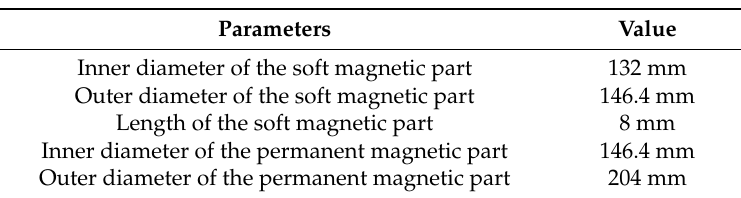
Table 2. The optimized